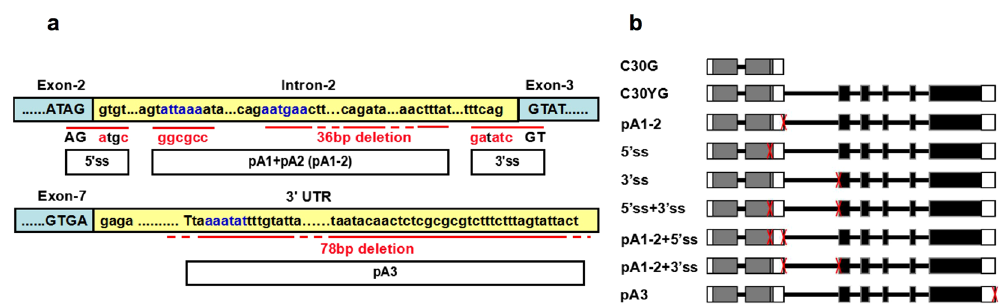
Figure 3. Mutagenesis of the OXT6 gene. ( a ) Illustrations of the 5 ′ ss, 3 ′ ss, pA1-2 and pA3 mutations. Intron-2 and 3 ′ UTR are shaded in yellow while exons are shaded in blue. Dots ( … ) represent omitted nucleotide sequences (not drawn in scale). The presumed NUE are indicated in blue, and the mutated nucleotides are indicated in red. ( b ) Illustrations of the complementary controls and seven OXT6 mutation constructs. Mutated regions are marked with red